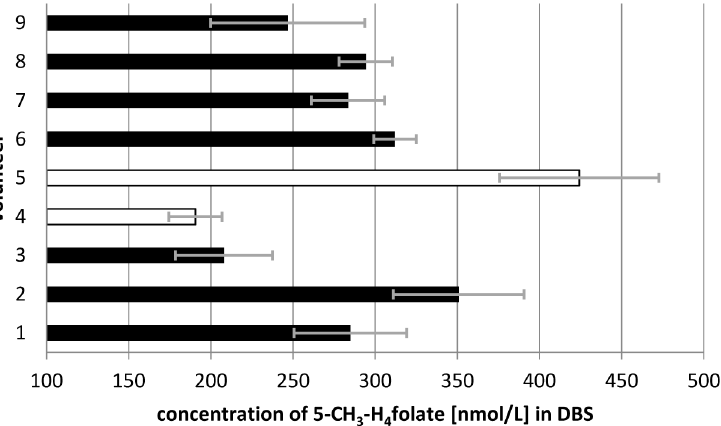
Fig 8. Screening of whole blood 5-CH 3 -H 4 folate in whole blood dried blood spots from eight volunteers.